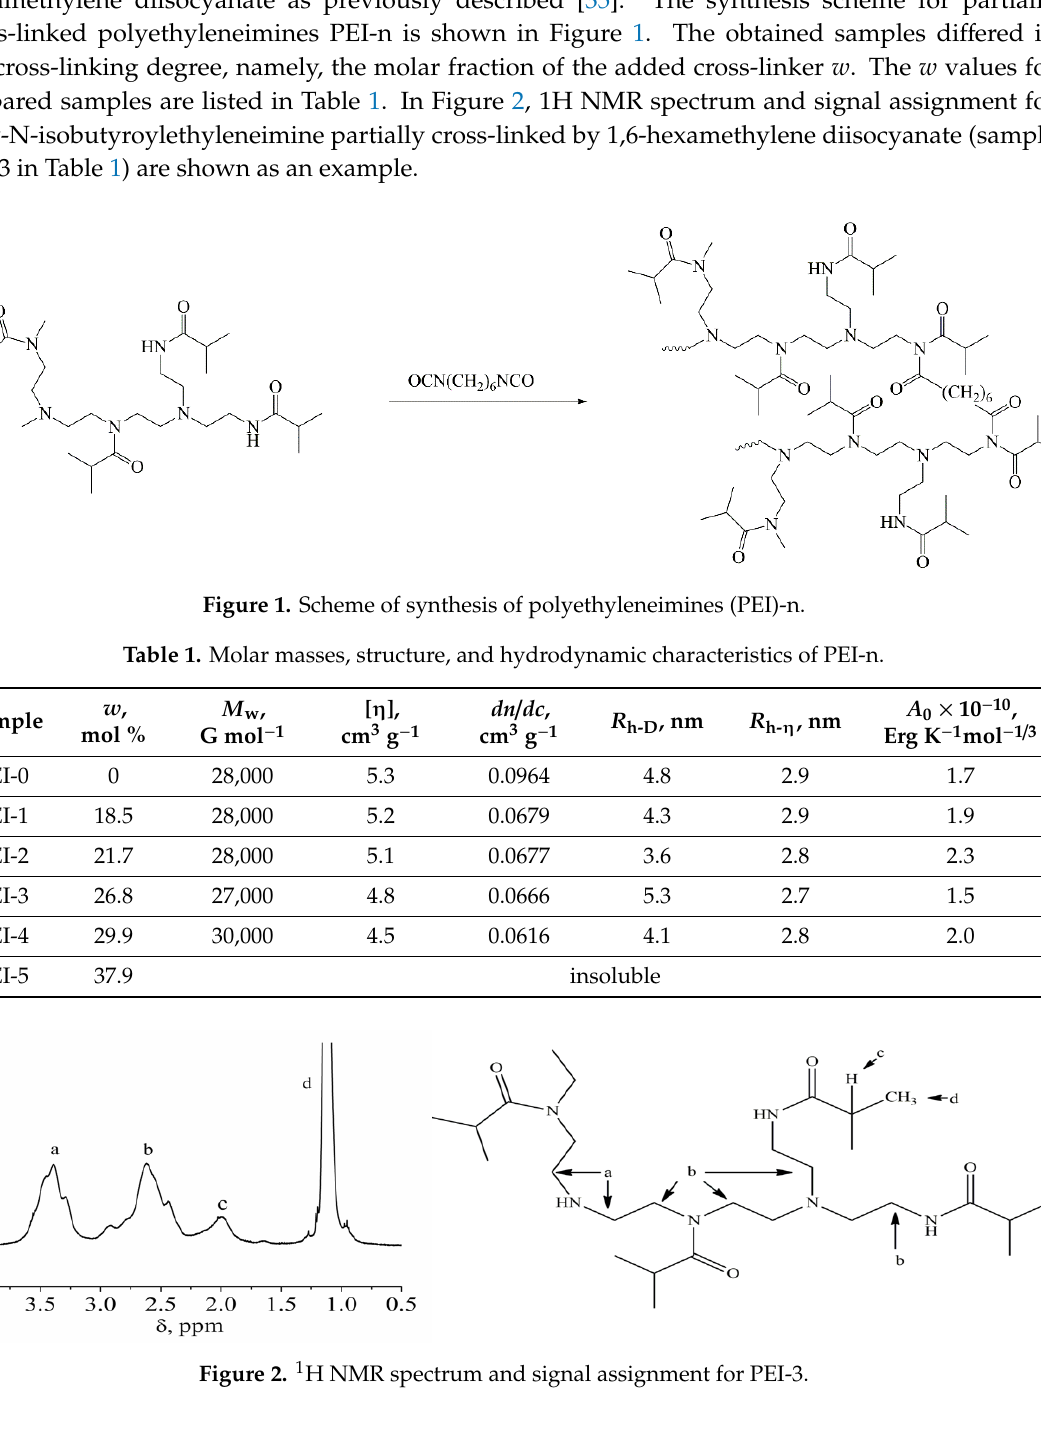
Figure 2. 1 H NMR spectrum and signal assignment for PEI-3.